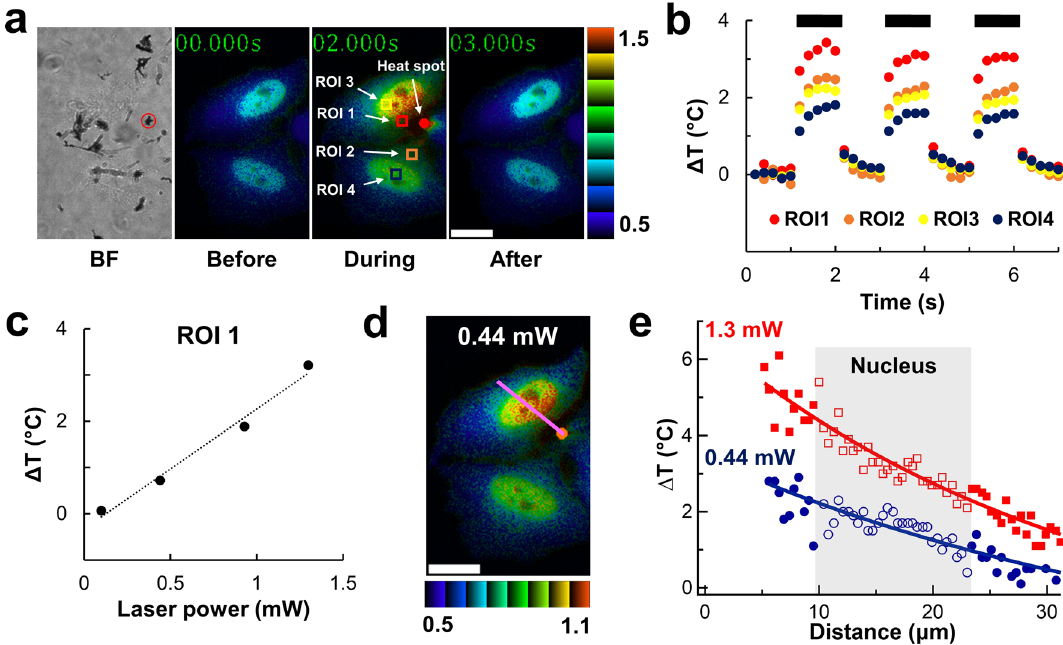
Figure 4. Application of ELP-TEMP to monitor quick temperature rise in live HeLa cells with a local heat spot. ( a ) Bright-field (BF) and pseudo-colored ratio images of HeLa cells stably expressing ELP-TEMP before, during, and after local heating. The red circle indicates the CNT cluster, i.e., the heat spot, whereas squares indicate regions of interest (ROI). ( b ) A plot of temperature increment Δ T as the function of time in ROIs 1–4. The temperature of ROI 1 and 2 was estimated from the cytoplasm calibration curve, whereas the temperature of ROI 3 and 4 was estimated from the nucleus calibration curve in Fig. S5, respectively. A CNT cluster located near two cells was irradiated with a 638 nm laser beam at a power of 1.3 mW. Black lines indicate the periods of laser irradiation. ( c ) A plot of Δ T in ROI 1 as a function of the laser power at 638 nm. ( d ) A pseudo-colored ratio image of HeLa cells stably expressing ELP-TEMP under local heating with the laser power of 0.44 mW. A line indicates ROI. ( e ) A plot of Δ T of the line in panel ( d ) against the distance from the heat spot. Closed and opened blue circles represent Δ T in the cytoplasm and nucleus, respectively, with the laser power of 0.44 mW, whereas closed and opened red squares represent Δ T in the cytoplasm and nucleus, respectively, with the laser power of 1.3 mW. The transparent box indicates the nucleus area. The medium temperature was 34 °C. The color bar indicates fluorescence ratio mV/mT. Scale bars, 20